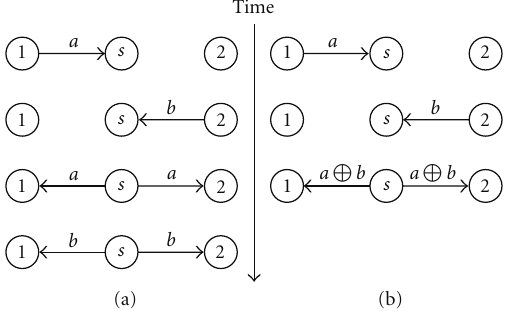
Figure 1: Bidirectional communication through satellite. With the traditional method (a) the satellite (s) can receive and retransmit one message at a time. With network coding (b) a xor b is broad- casted to both ground nodes, which are able to decode the respective messages.